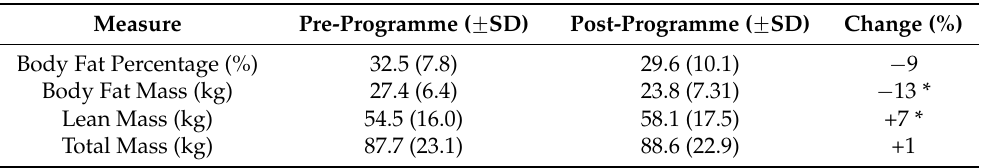
Table 5. Pre and post programme anthropometric measures.